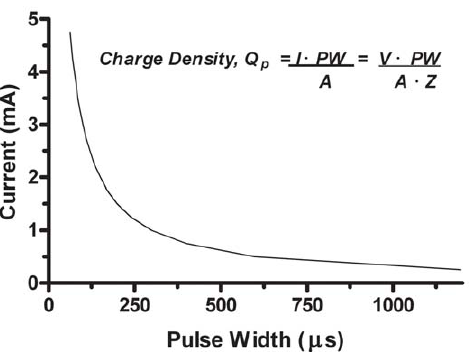
Figure 2. Plot of current vs. pulse width values yielding a charge density (Qp) of 30 m C/cm 2 /phase. For this study, DBS delivery was programmed in constant current mode. To determine initial DBS parameter settings of current (I) and pulse width (PW) that could be presumed not to cause tissue damage, a safety threshold curve was generated from PW and I combinations that yielded a charge density (Qp) of 30 m C/cm 2 /phase – a clinical reference value used as a conservative safety threshold for DBS applications. The equation insert in the graph was used to calculate corresponding PW values for a range of I values, with A=0.01 cm 2 for the area of the electrode we used and Qp=30 m C/cm 2 /phase. Thus, any I and PW combinations to the left of the safety-threshold curve could initially be